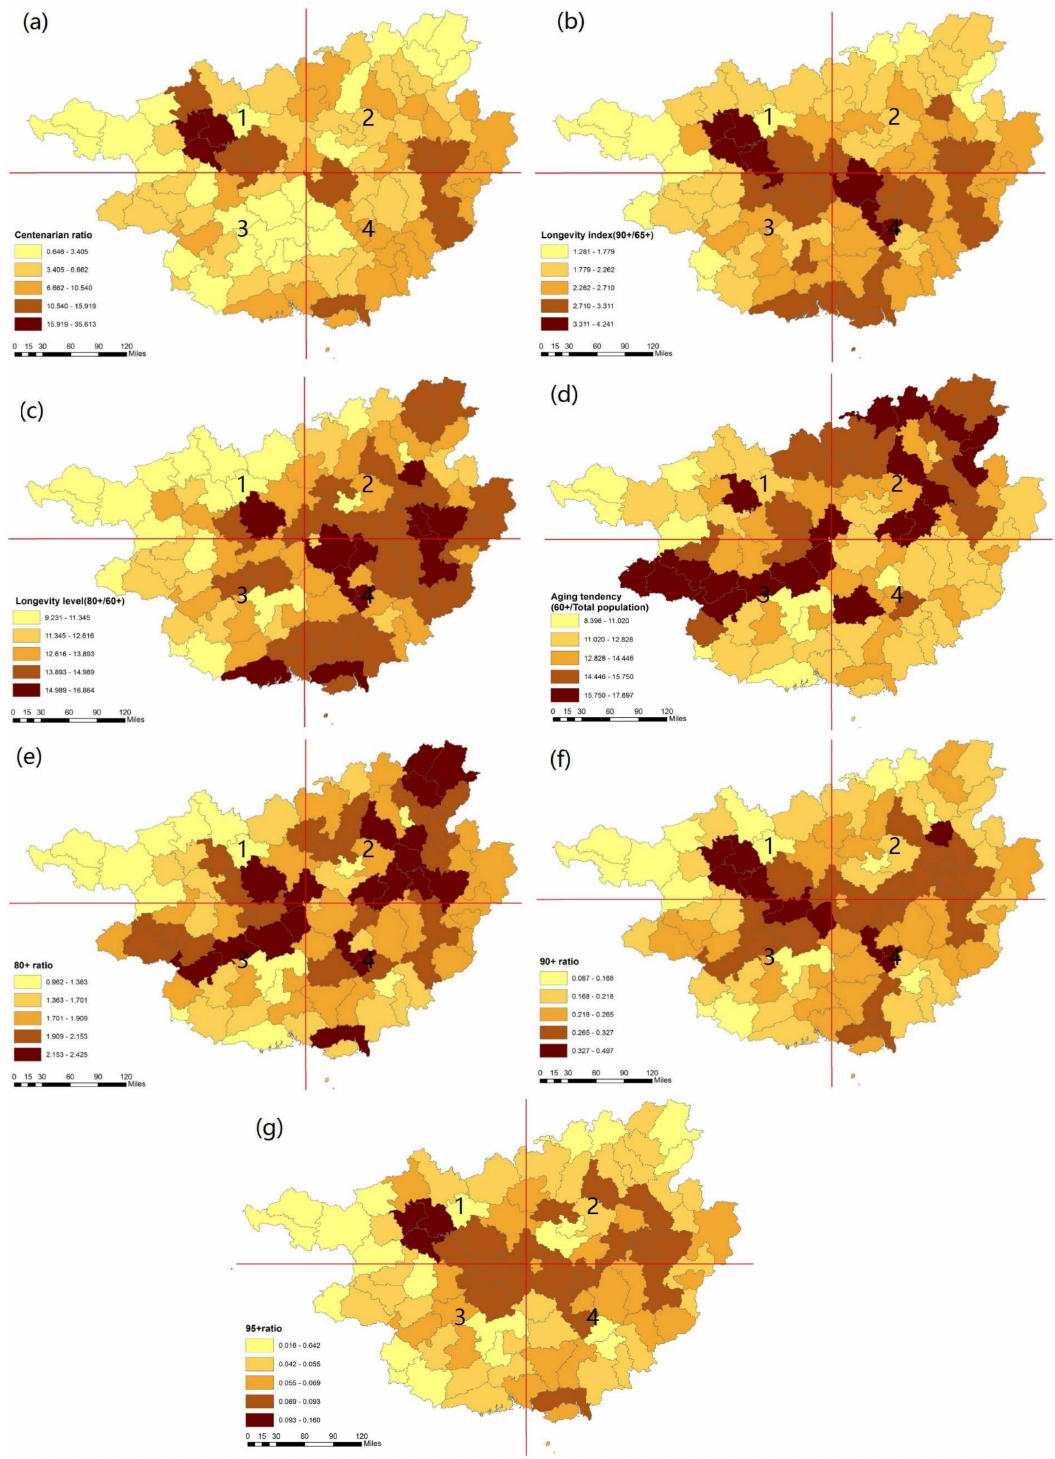
Figure 3. Spatial distribution of seven longevity indicators in Guangxi ( a – g